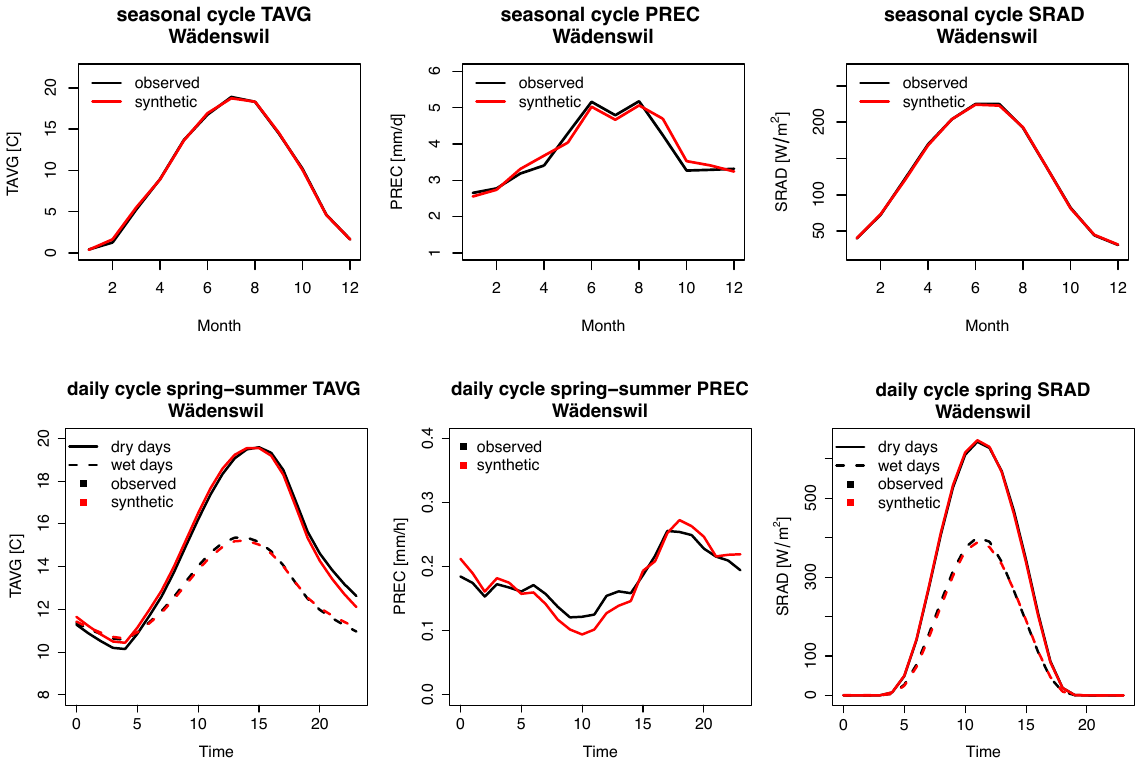
Fig. 2. Seasonal (top row) and daily (bottom row) cycles of mean temperature (TAVG), precipitation (PREC) and global solar radiation (SRAD) for the station W¨adenswil. Synthetic data are displayed in red, observed data in black. Daily cycles are shown for spring and summer in case of temperature and precipitation, and for spring in case of solar radiation (as only the codling moth flight start in spring is influenced by solar radiation). For temperature and radiation, results are presented separately for dry and wet days. Database is 29yr of in situ observations (1981–2009) and 100yr of synthetic